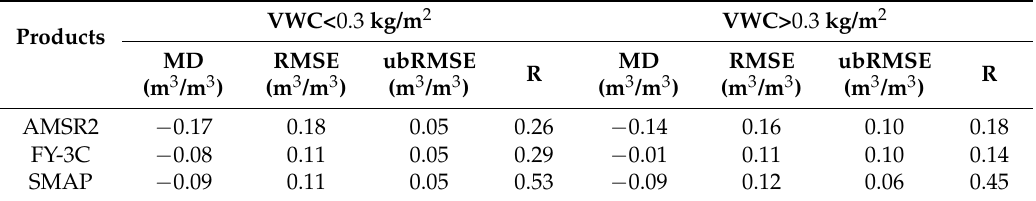
Figure 11. Comparison of the estimated soil moistures from FY-3C, AMSR2, and SMAP against in-situ measurements under different vegetation water content (VWC, W c ) conditions. VWC was determined using Equations (1) and (2). Table 8. The statistical indicators for FY-3C, AMSR2, and SMAP soil moisture retrievals under the two contrasting vegetation water content (VWC, W c )